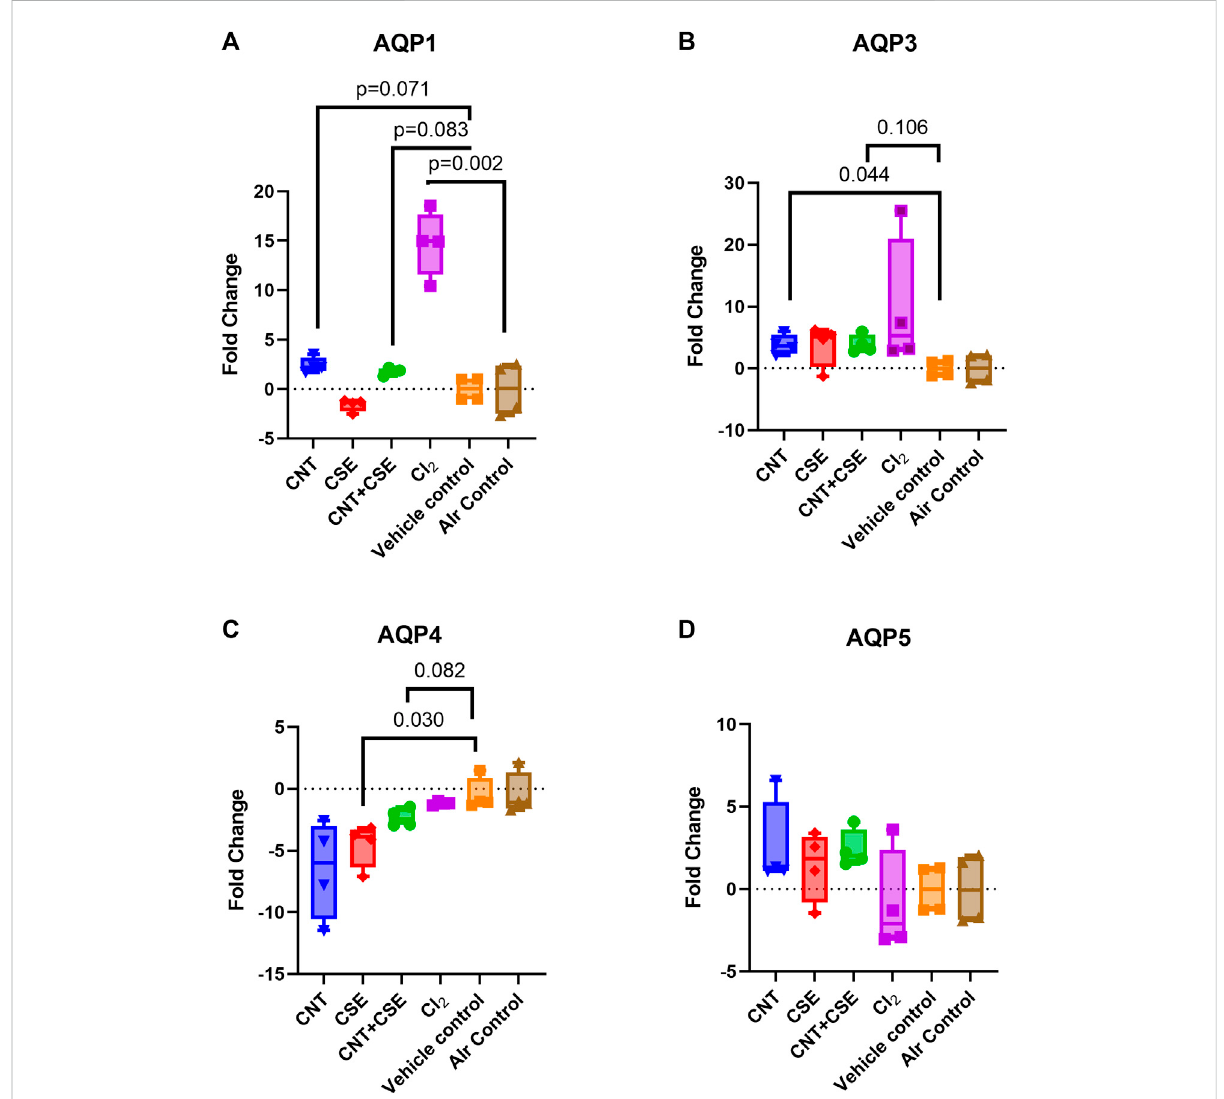
FIGURE 1 Expression of lung aquaporins [AQP1 (A) , AQP3 (B) , AQP4 (C) , and AQP5 (D) ] in mice subjected to different respiratory exposure regimens namely, acute chemical exposure to Cl 2 gas, chronic particulate exposure to carbon nanotubes (CNT), chronic chemical exposure to cigarette smoke extract (CSE), and a chronic co-exposure to CNT + CSE. Mice (6 – 8 weeks-old) were exposed via inhalation to Cl 2 gas (@200 ppm) for 5 min and via oropharyngealadministration toCNT suspension(2.8 mg/kgbody weightsingle doseonday0),CSEsuspension(30 µl/mousedaily), or the combination regimen (CNT + CSE) for a duration of 28 days. Total RNA of the lung tissue from each mouse was subjected to qRT-PCR based gene expression analysis for individual aquaporins (AQPs 1, 3, 4, and 5) represented as fold change, as described under Materials and Methods section. Statistical differences are represented by p